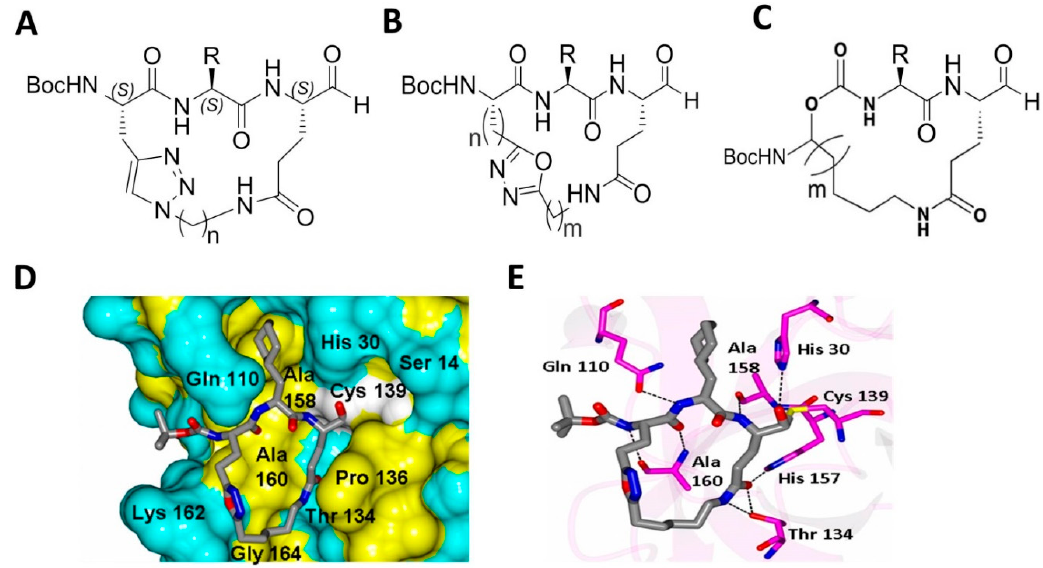
Figure 10. Examples of macrocyclic NV 3CL Pro inhibitors. ( A – C ). Three different classes ( A , B , and C ) of macrocyclic inhibitors were synthesized. The P 2 position, and the length and nature of the linker were examined for optimal efficacy against the enzyme and viral replication. ( D – E) X-ray